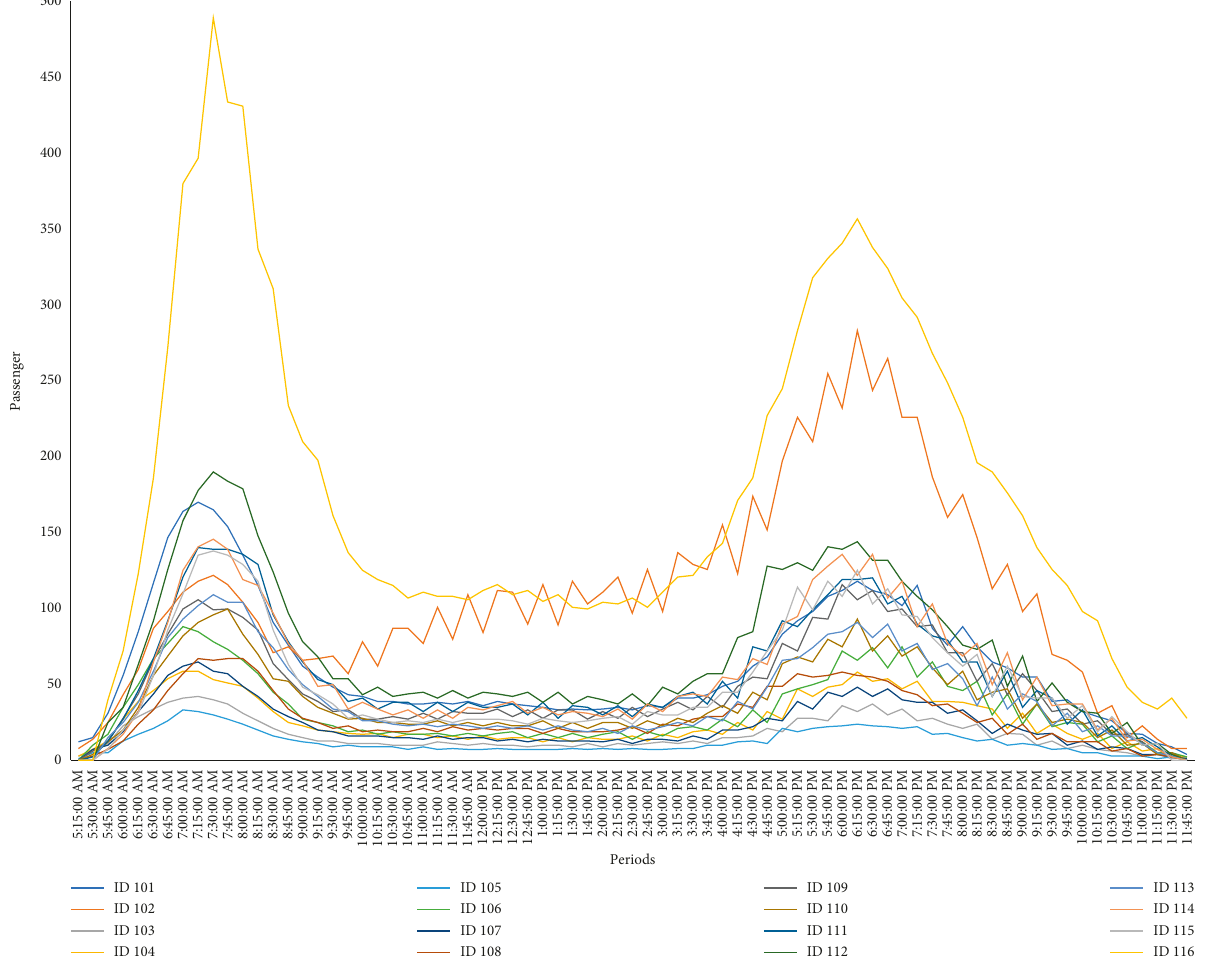
Figure 3: The average of passengers in each